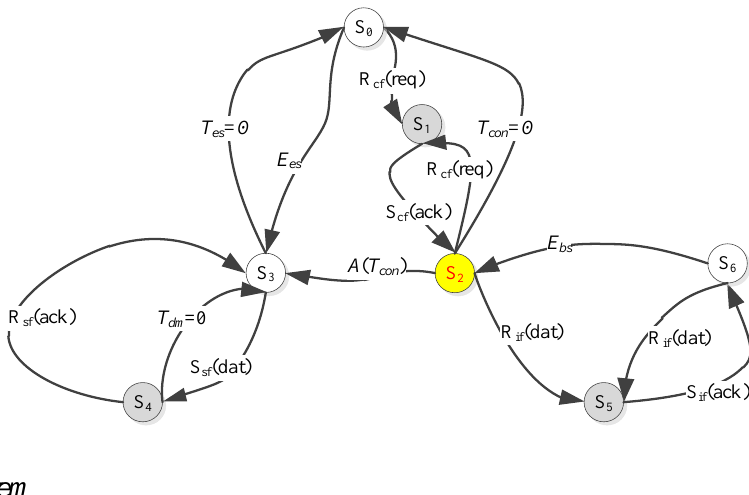
Figure 7. State-Transition Diagram of BUS